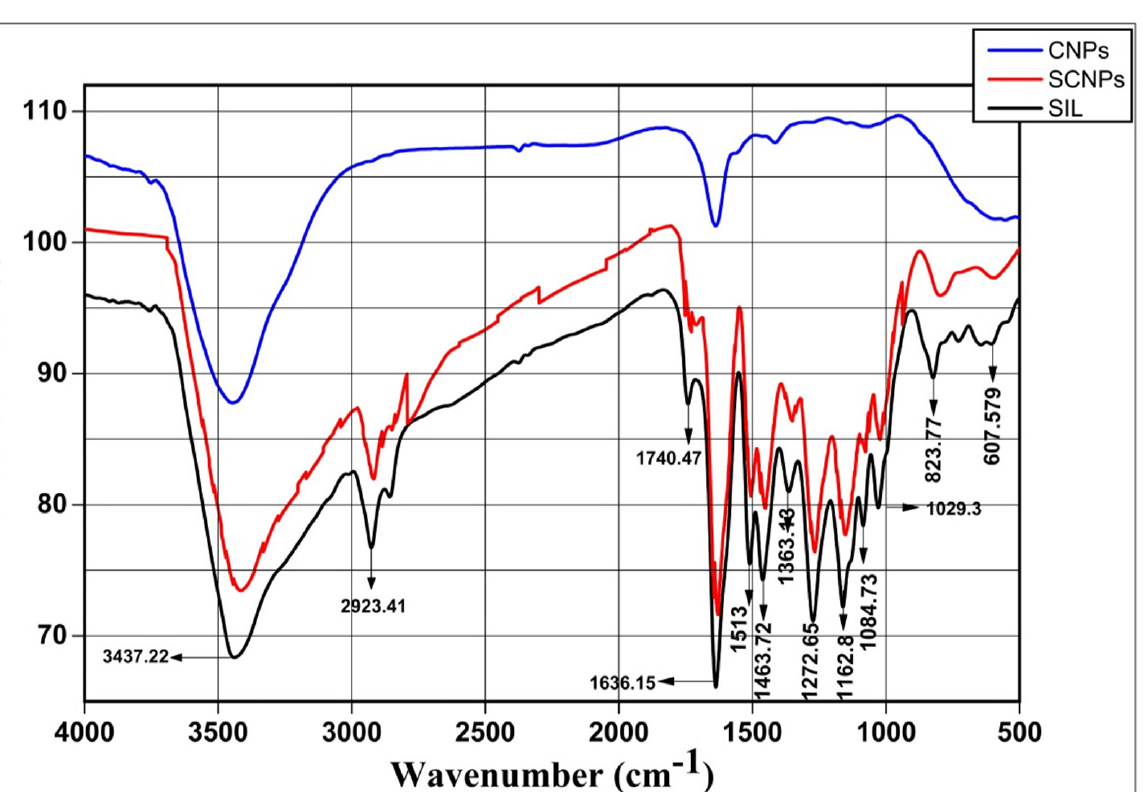
Figure 3. FT-IR spectra of SIL, CNPs, and SCNPs.